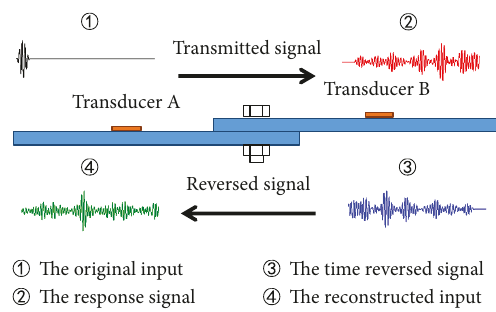
Figure 1: Illustration of the time reversal principle in a lap